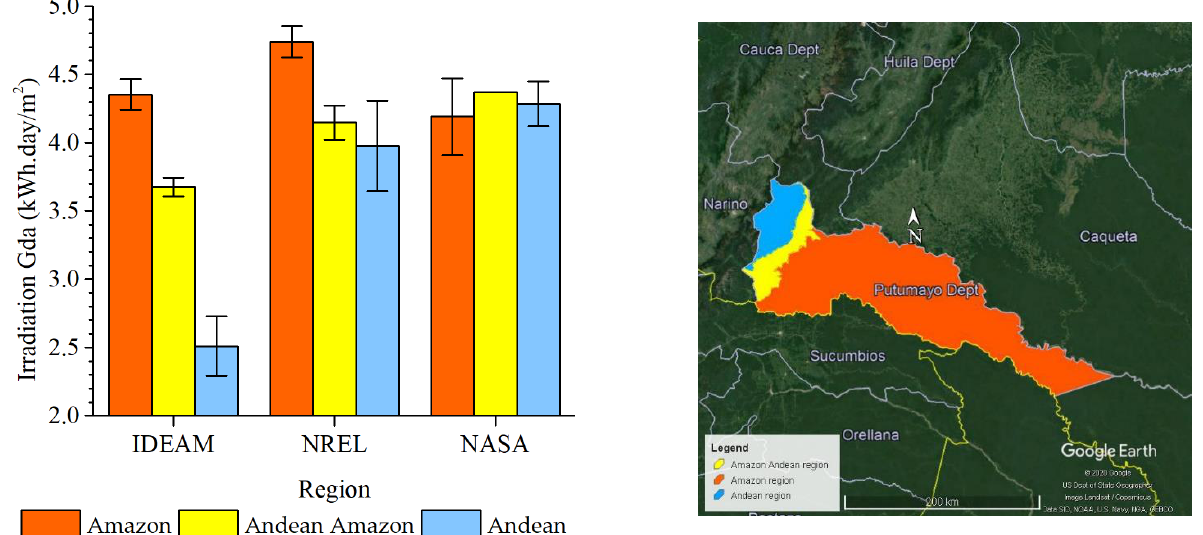
Figure 7. Annual daily average of radiation G da ( 0 ) for the IDEAM station areas using different databases.